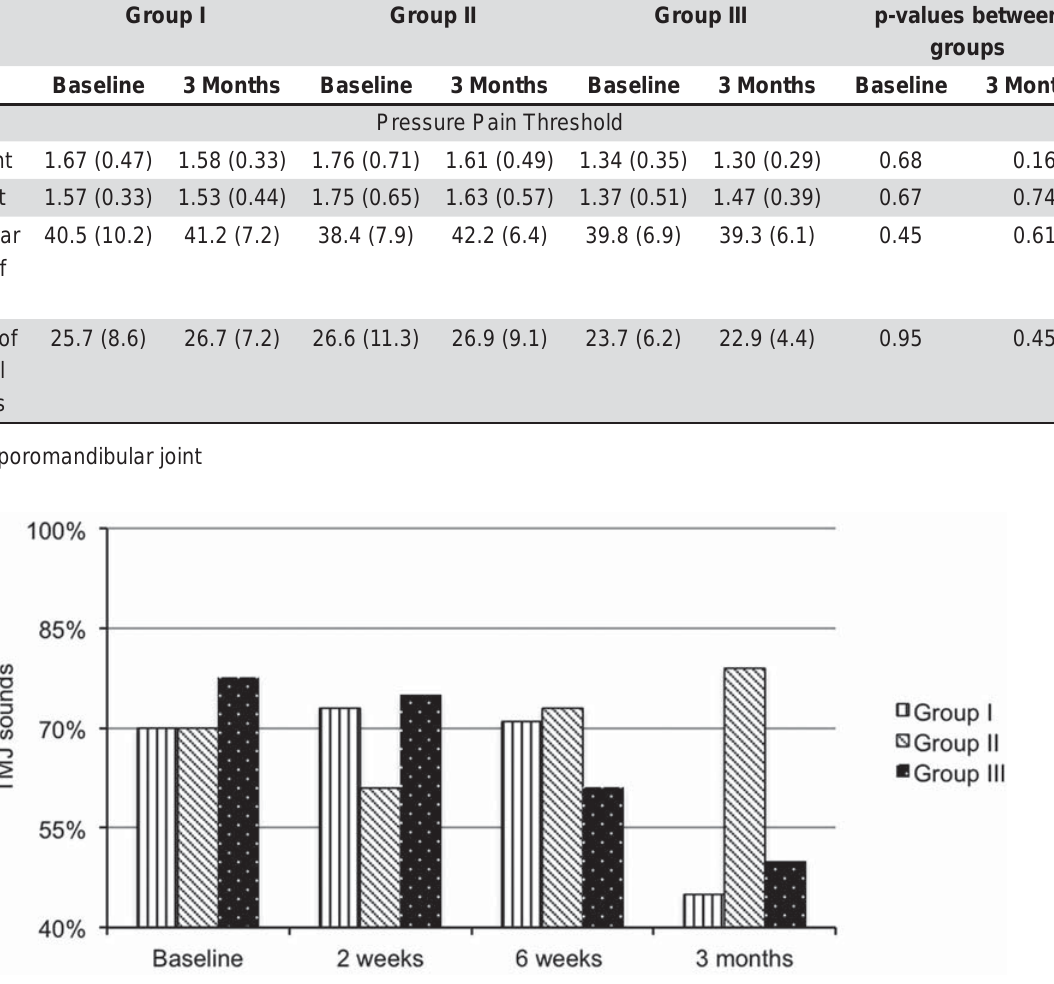
Figure 3- Presence of temporomandibular joint (TMJ) clicking sounds for the three groups at different times. For each subject, two TMJs were considered (n=120)